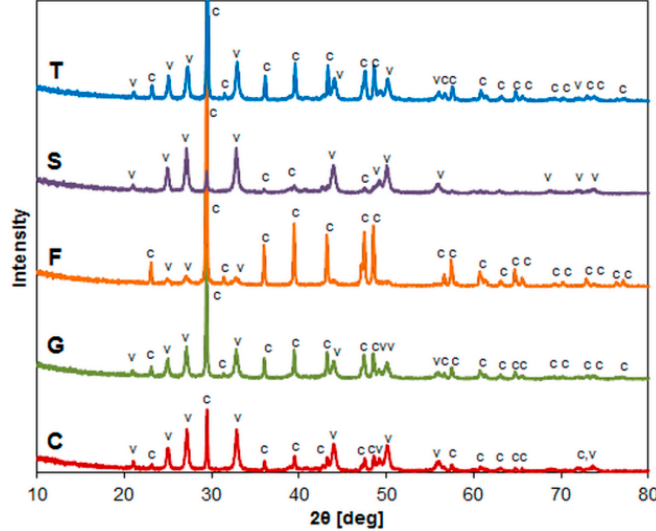
Figure 3. XRD patterns of calcium carbonate particles precipitated without additives ( C ), with glucose ( G ), fructose ( F ), sucrose ( S ) and trehalose ( T ).